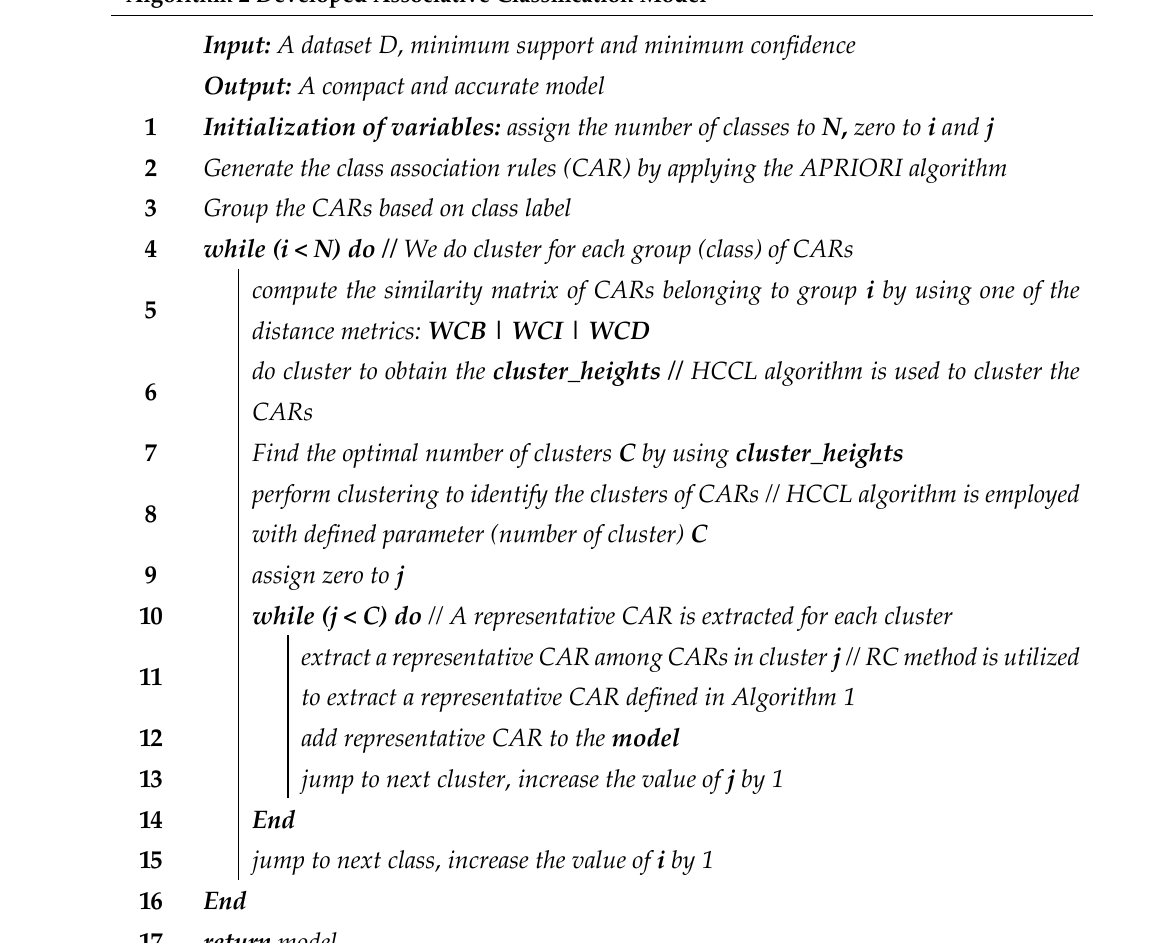
Algorithm 2 Developed Associative Classification Model